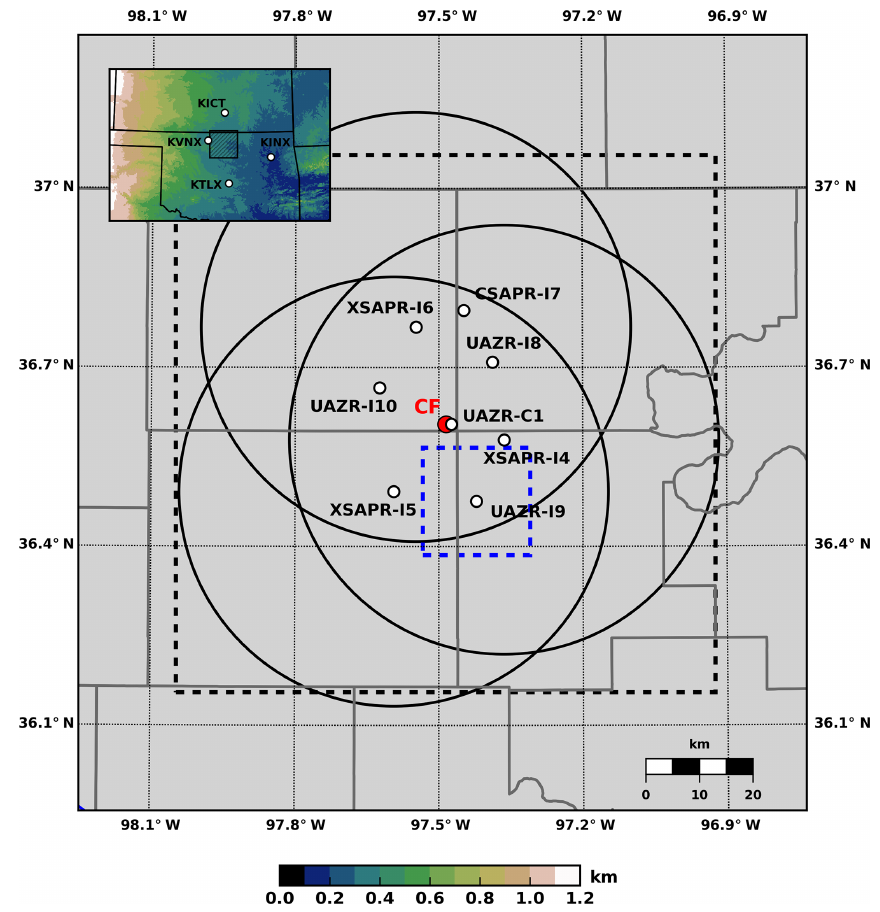
Figure 1. ARM SGP site with locations of scanning and profiling radars surrounding the Central Facility (CF). Dashed black box in main panel corresponds to a 100km × 100km horizontal analysis domain (also shown in inset panel). Black circles are 40km XSAPR maximum ranges (see Table 2). The separate analysis domain used in the sensitivity analysis (see Sect. 4) is shown as the dashed blue box surrounding the southeast radar wind profiler (UAZR-I9). The inset panel provides the large-scale view of the region including surface elevation in kilometers above mean sea level and the closest NEXRAD WSR-88Ds. Table 2. Operational parameters of the ARM XSAPR, CSAPR, UAZR, and NEXRAD WSR-88D (KVNX) radars during MC3E (convection